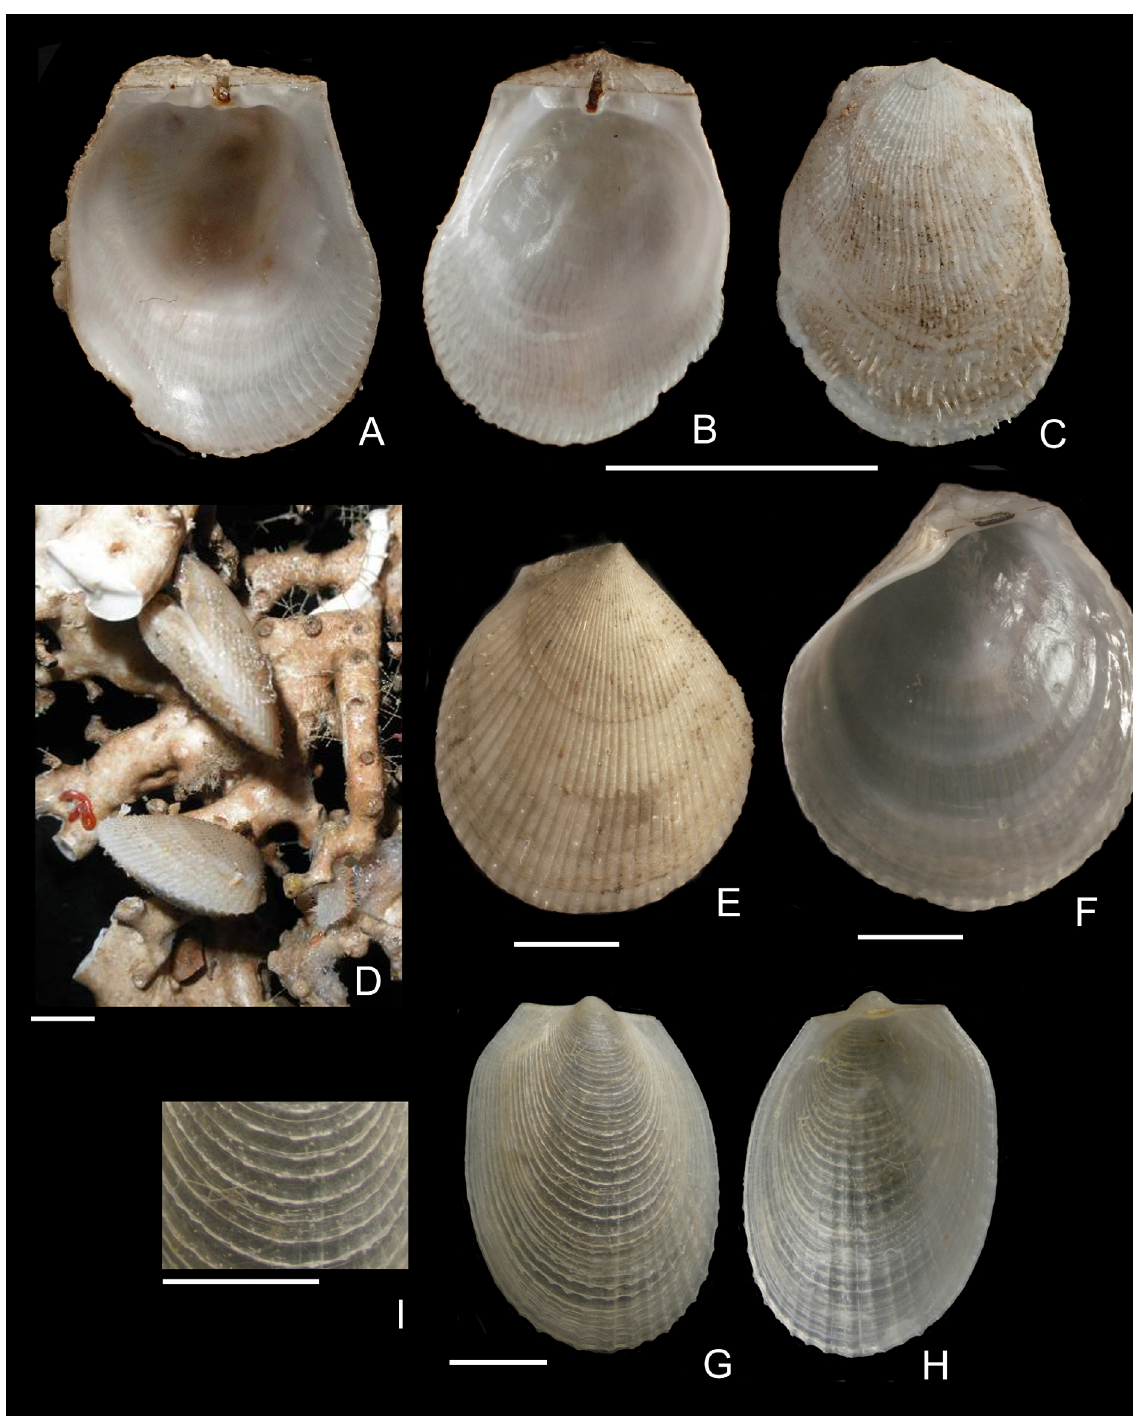
Fig. 37. Limidae, Spondylidae. A–C . Spondylus gussonii Costa, 1830, ECOMARG 0709, V5, 876